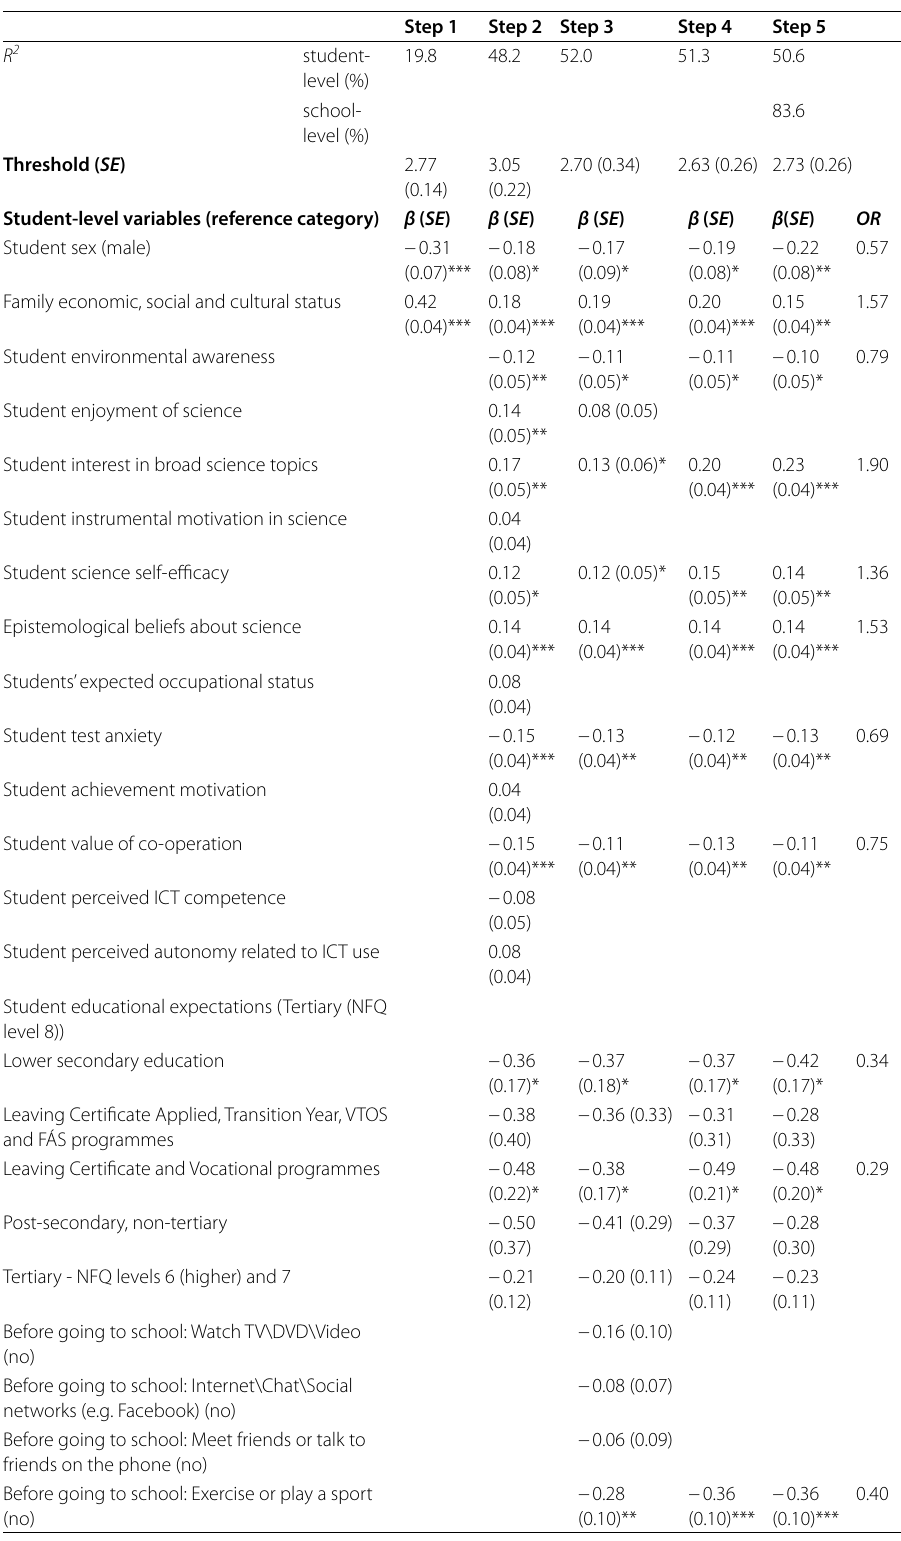
Table 6 Hierarchical two-level binary logistic regression model for high achievement in science, PISA